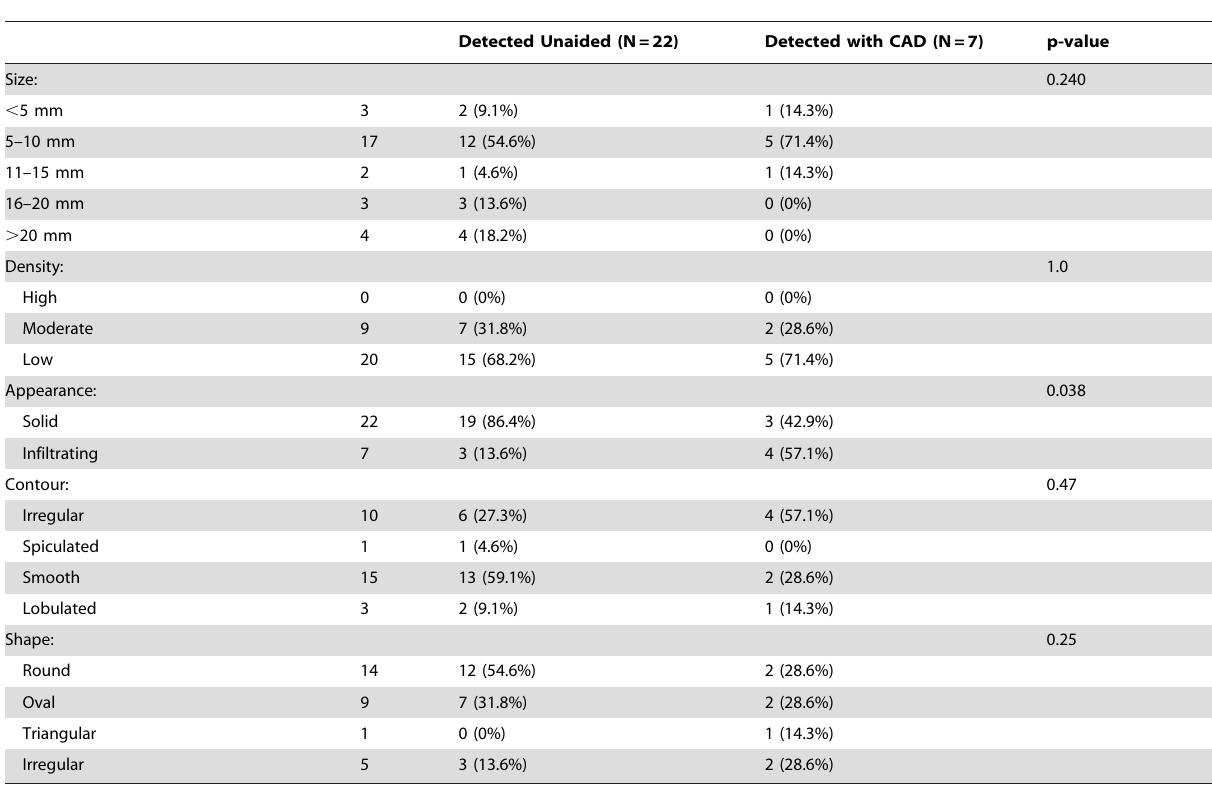
Table 4. Characteristics of actionable nodules identified on the baseline